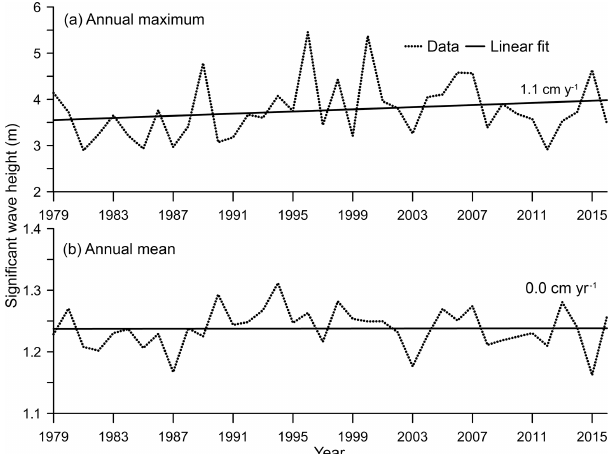
Figure 11. Variation of the (a) annual maximum and (b) annual mean H s at the shallow locations based on ERA-Interim data. The solid line indicates the trend in H s during 1979 to 2016.